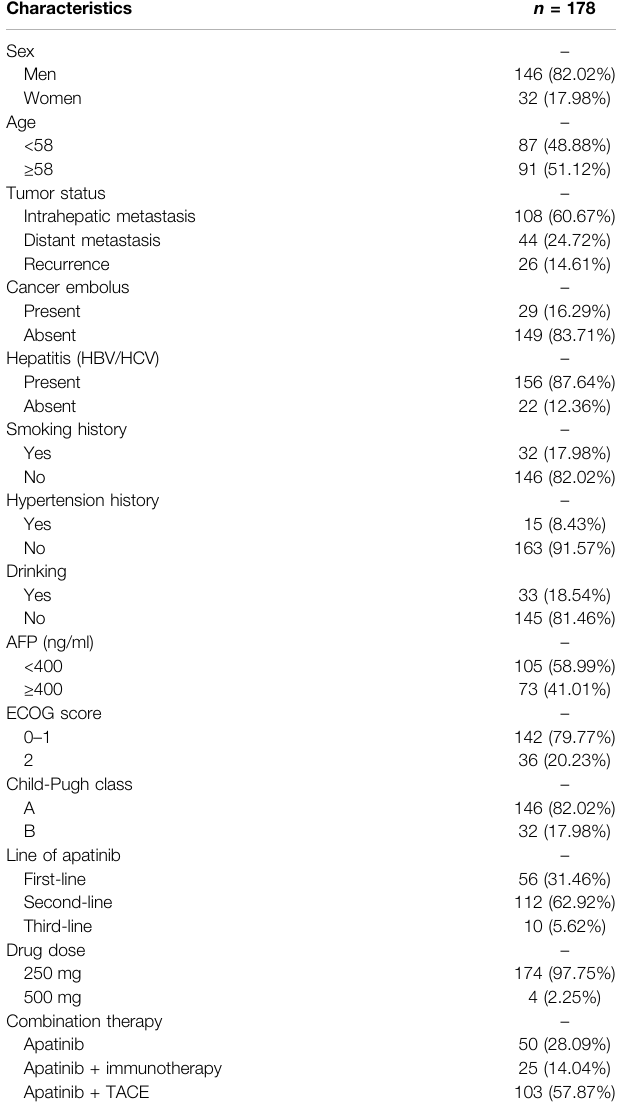
TABLE 1 | Baseline characteristics of the patients treated with apatinib.